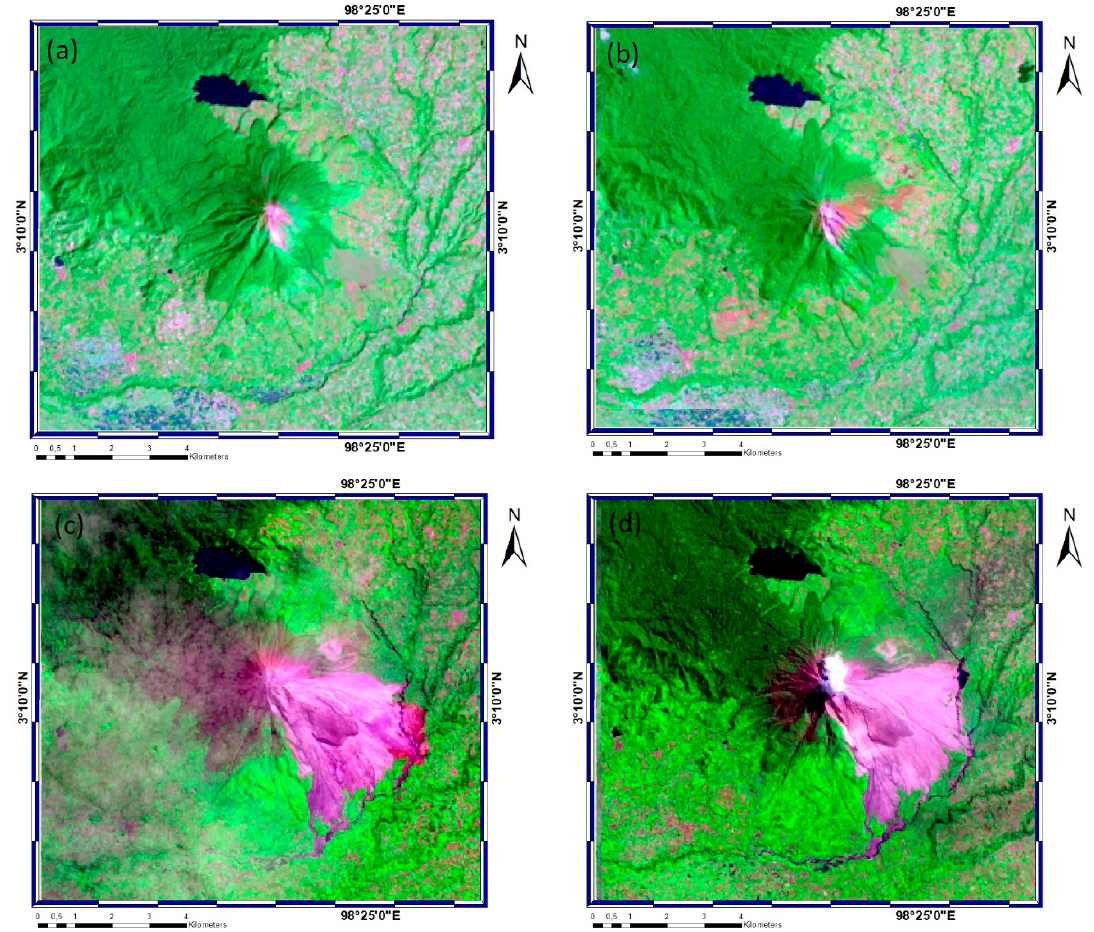
Figure 2. Landsat 7 (Bands 7, 4 and 2) and Landsat 8 (bands 7, 5 and 3) imagery data of Mount Sinabung taken in the year shown below each image. We can see the changes of pyroclastic deposits of Mount Sinabung from before eruption ( a ) 7 February 2007, after the first eruption on ( b ) 17 November 2011, after the second eruption on ( c ) 7 July 2016, and current pyroclastic deposits on ( d ) 28 July 2017, marked with grey color in the middle of the image.